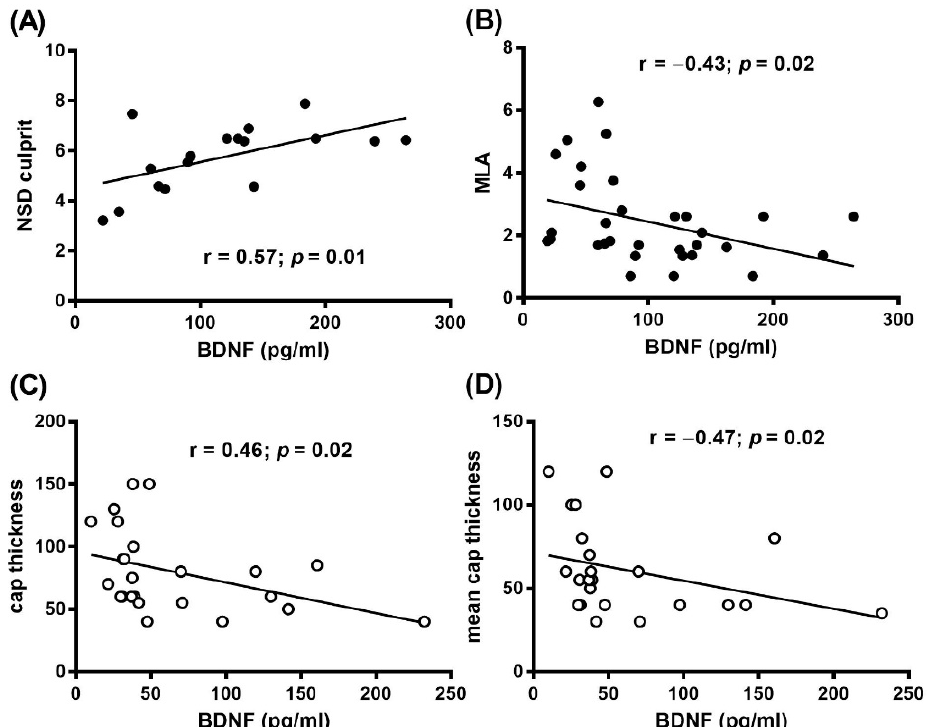
Figure 4. Relation between circulating BDNF levels and OCT features. Correlation between plasma BDNF and ( A ) MØI in terms of normalized standard deviation (NSD) culprit, ( B ) Minimal Luminal Area (MLA), and ( C ) cap thickness and ( D ) mean cap thickness in ( A , B ) SA (black dots), and ( C , D ) AMI (white dots) patients.